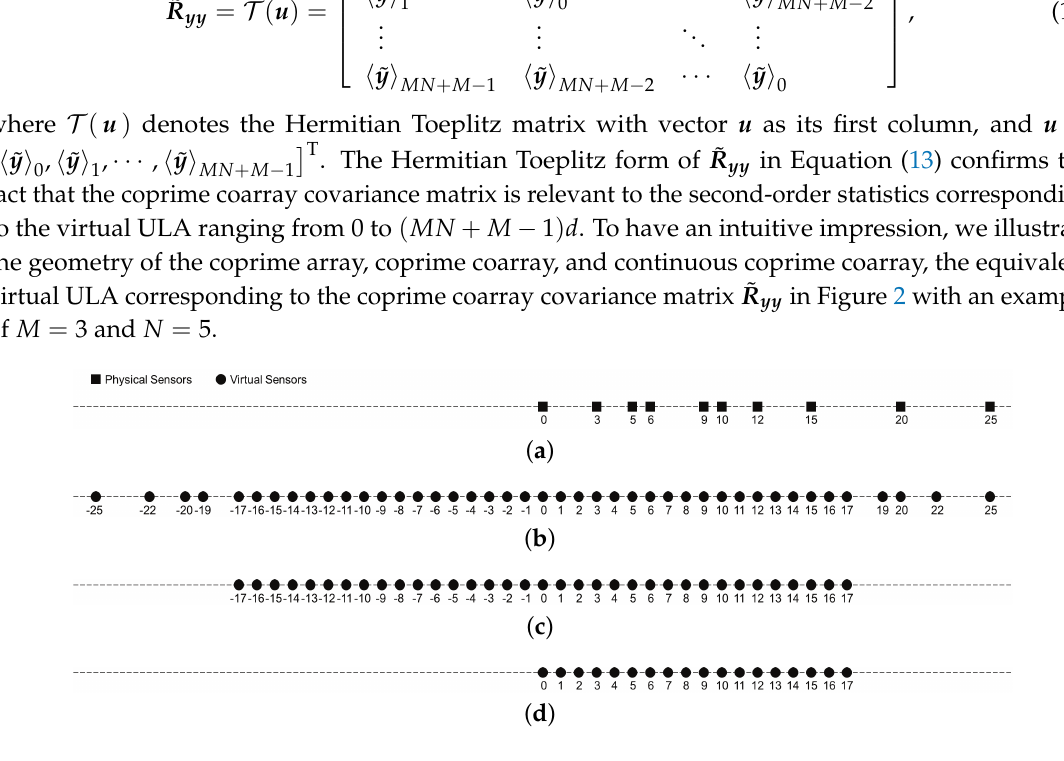
Figure 2. Illustration of each array configuration with an example of M = 3 and N = 5, the unit spacing is d . ( a ) coprime array; ( b ) coprime coarray; ( c ) continuous part of coprime coarray; ( d ) the equivalent virtual ULA corresponding to the coprime coarray covariance